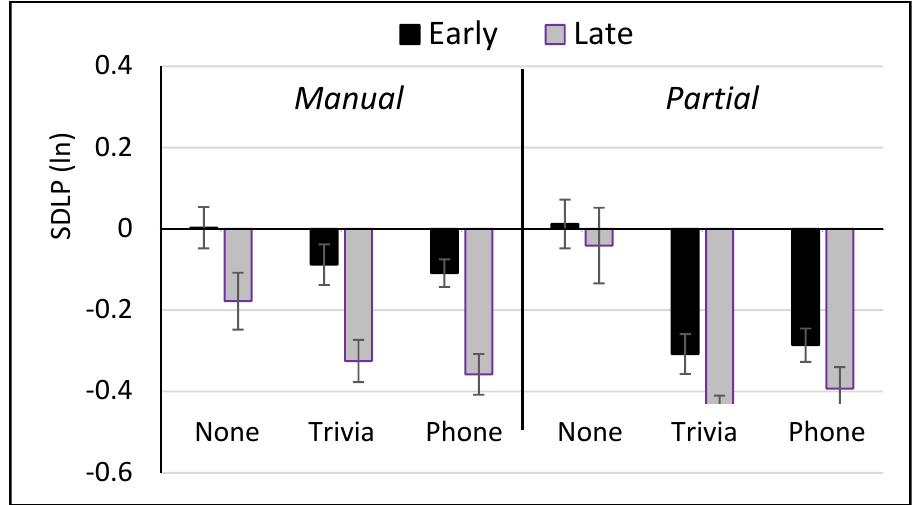
Figure 6. SDLP as a function of automation and secondary media conditions, early and late in the drive. Error bars are standard errors.